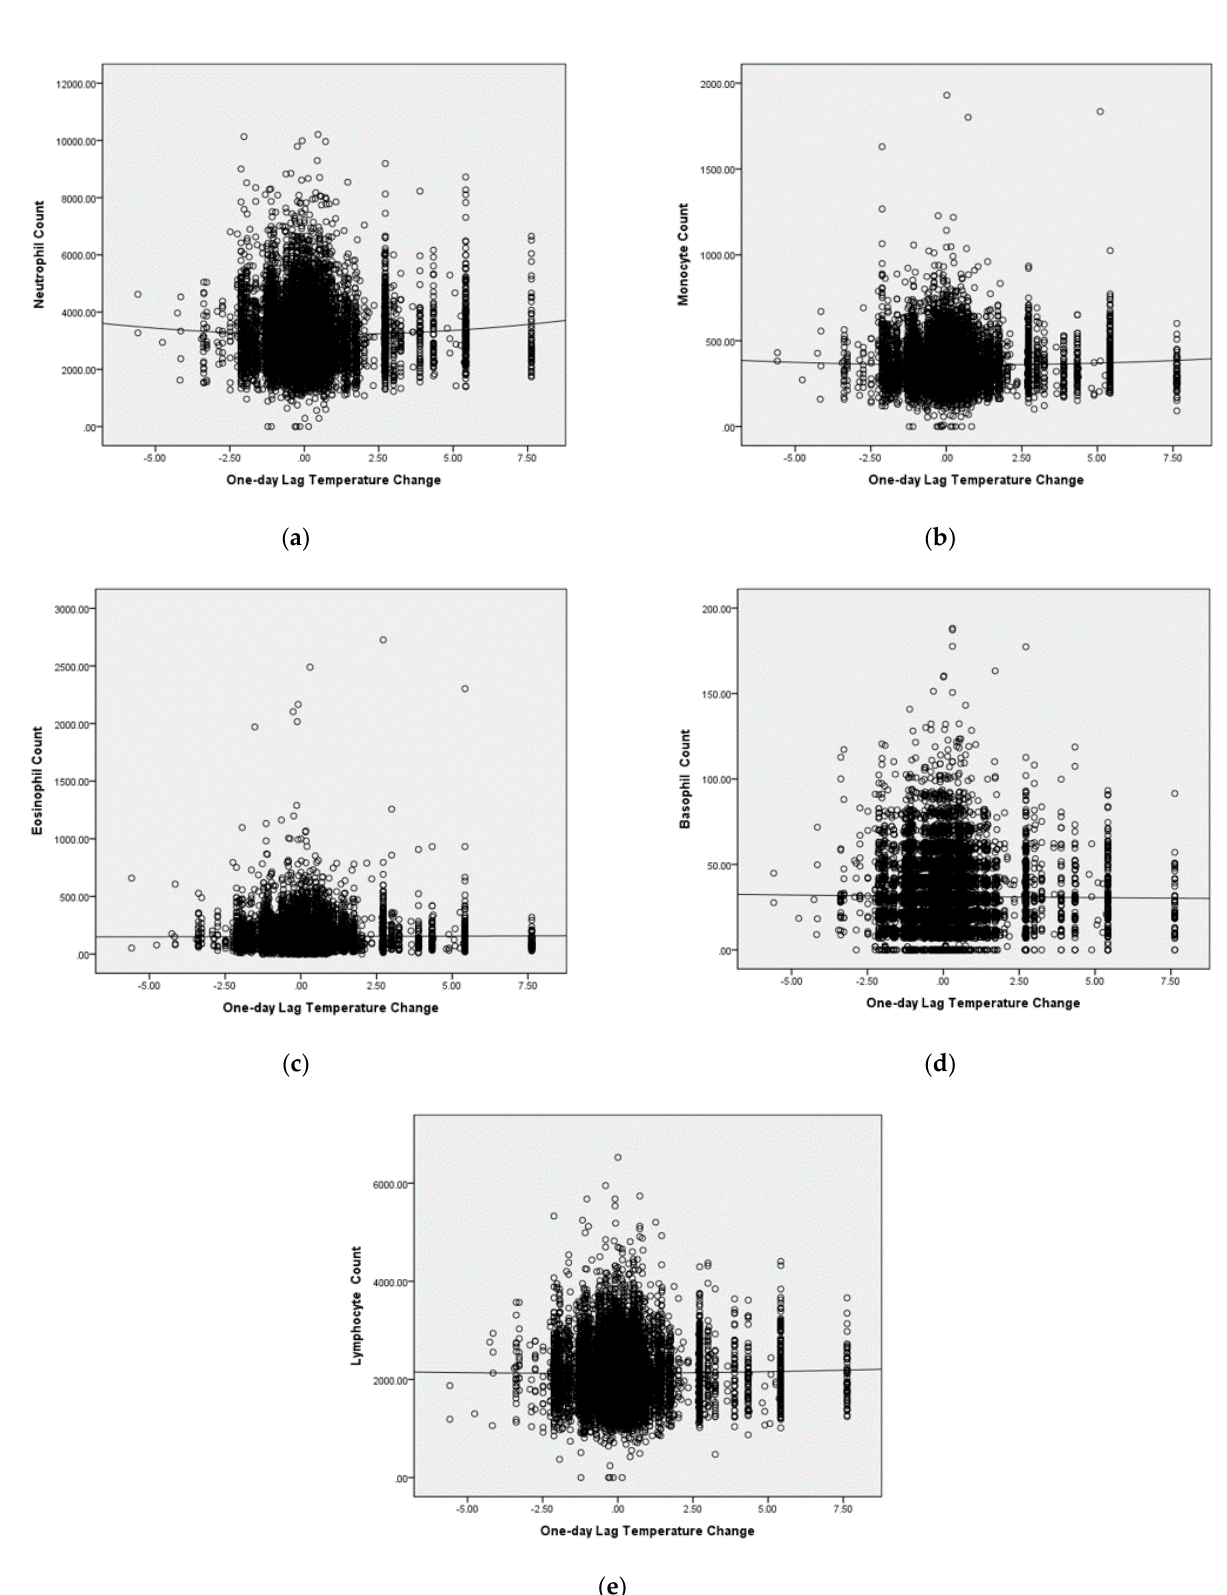
Figure 4. The scatter plot graphs of counts of WBC differential types and trend lines of GAM: ( a ) neutrophil, the p -value of GAM analysis is 0.000219; ( b ) monocyte, the p value of GAM analysis is 0.00000157; ( c ) eosinophil, the p value of GAM analysis is 0.000214; ( d ) basophile, the p value of GAM analysis is 0.0167; ( e ) lymphocyte, the p value of GAM analysis is